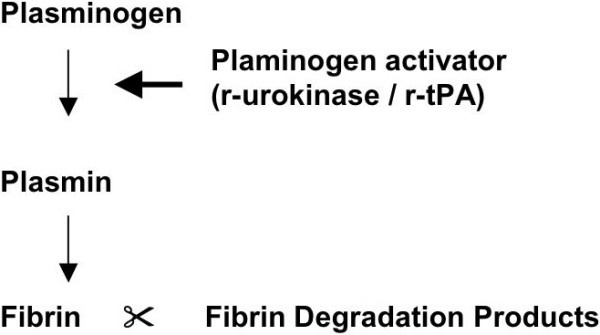
Fibrinolytic System.